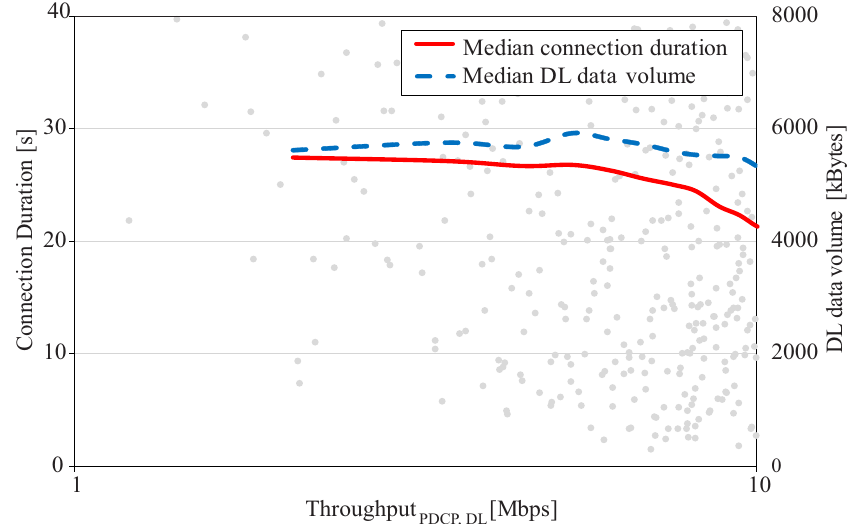
Figure 5. QoS and traffic indicators for a web browsing service (large objects).